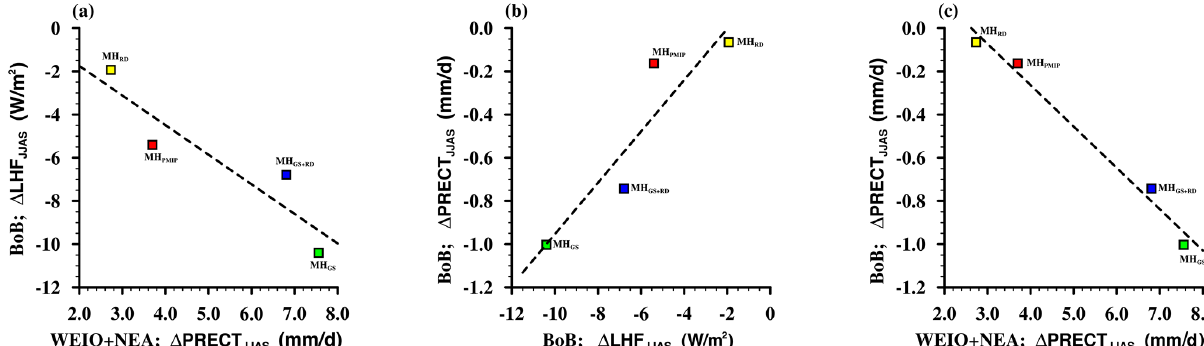
Figure 11. Scatter plot of summer (JJAS) changes between (a) latent heat flux over the Bay of Bengal (BoB, 10–20 ◦ N, 85–95 ◦ E; W/m 2 ) and precipitation over the western equatorial Indian Ocean (WEIO, 5 ◦ S to 5 ◦ N, 50–65 ◦ E; mm/d), and northeastern Africa (NEA, 10–20 ◦ N, 30–45 ◦ E), between (b) precipitation and latent heat flux over the BoB, and between (c) precipitation over the BoB and over WEIO + NEA. Changes are shown for the mid-Holocene-only orbital forcing (MH PMIP ) in red, the Sahara greening (MH GS ) in green, dust-only reduction (MH RD ) in yellow, and the Sahara greening with dust reduction (MH GS + RD ) in blue with respect to the PI reference